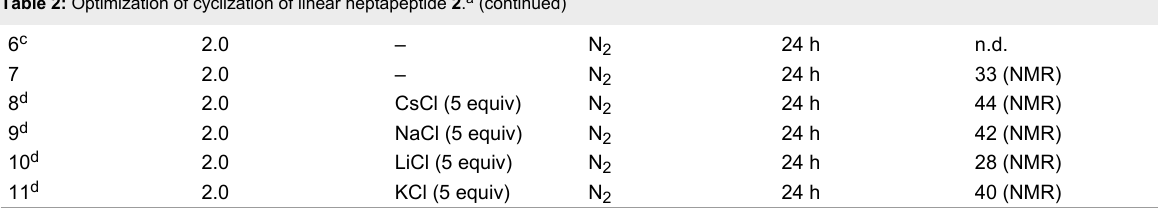
Table 2: Optimization of cyclization of linear heptapeptide 2 . a